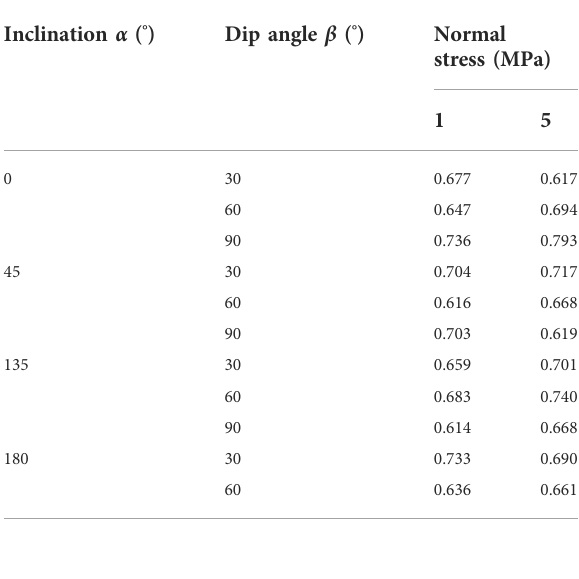
TABLE 1 Ratio of crack initiation and peak stress for each specimen.